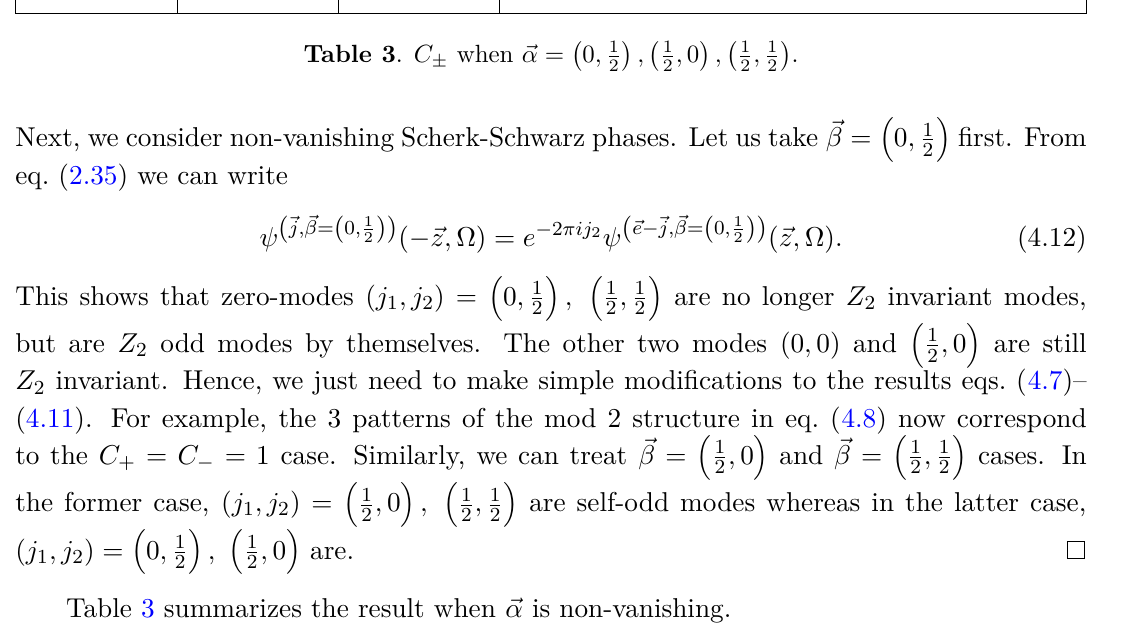
Table 3 . C ± when ~α =